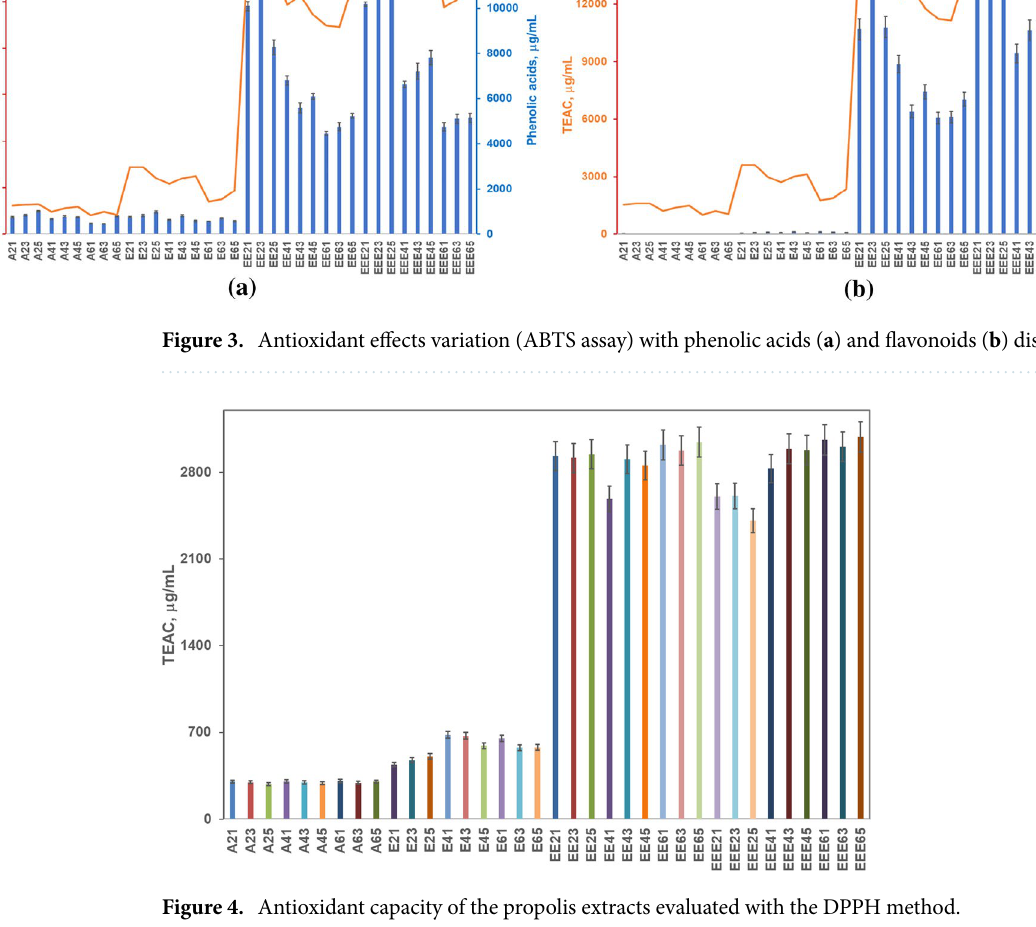
Figure 4. Antioxidant capacity of the propolis extracts evaluated with the DPPH